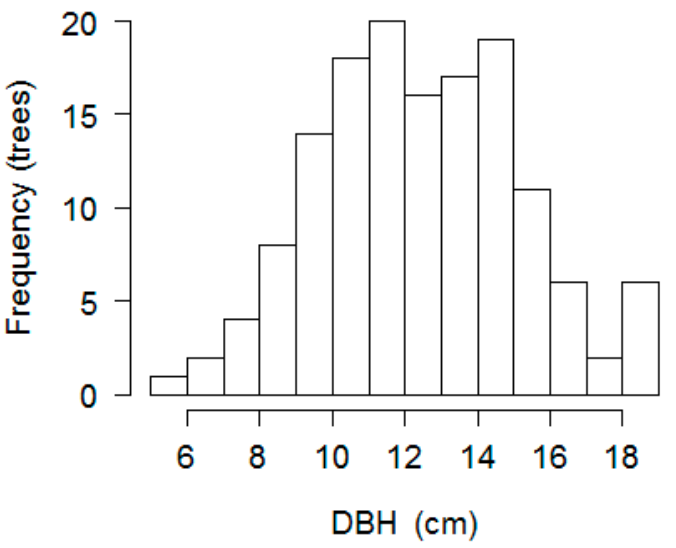
Figure A1. Histogram of tree DBH frequency at the three study sites. n = 144.